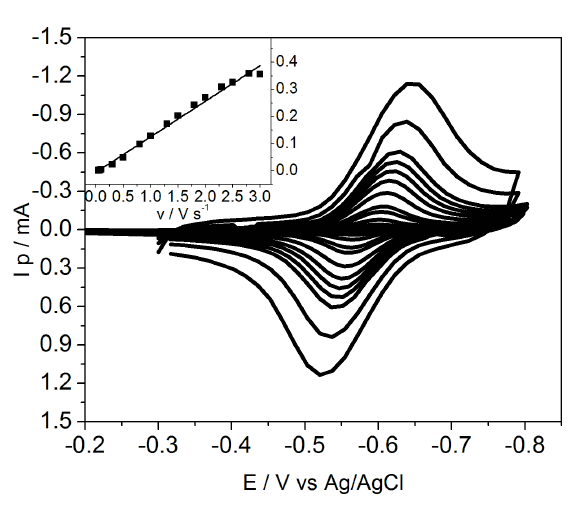
Figure 4: Cyclic voltammograms recorded at the increasing scan rate for mixed DPPTE/SWCNTs-DNR (1:5 w/w) layers transferred onto gold electrodes by means of LB method for end modification of nano- tubes. Inset: dependence of peak current vs scan rate.